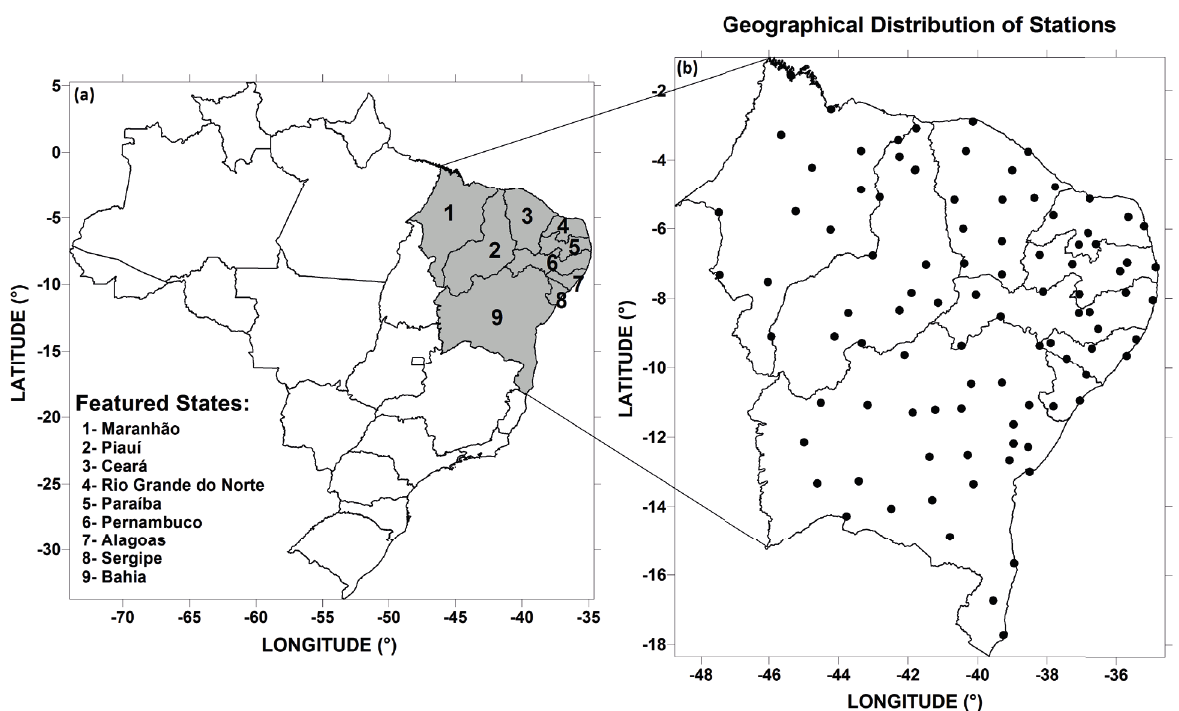
Figure 1. Map of Brazil highlighting the Northeast region (NEB) in gray, with numerically identifi ed states (a) , and the distribution of the 97 meteorological stations (b)